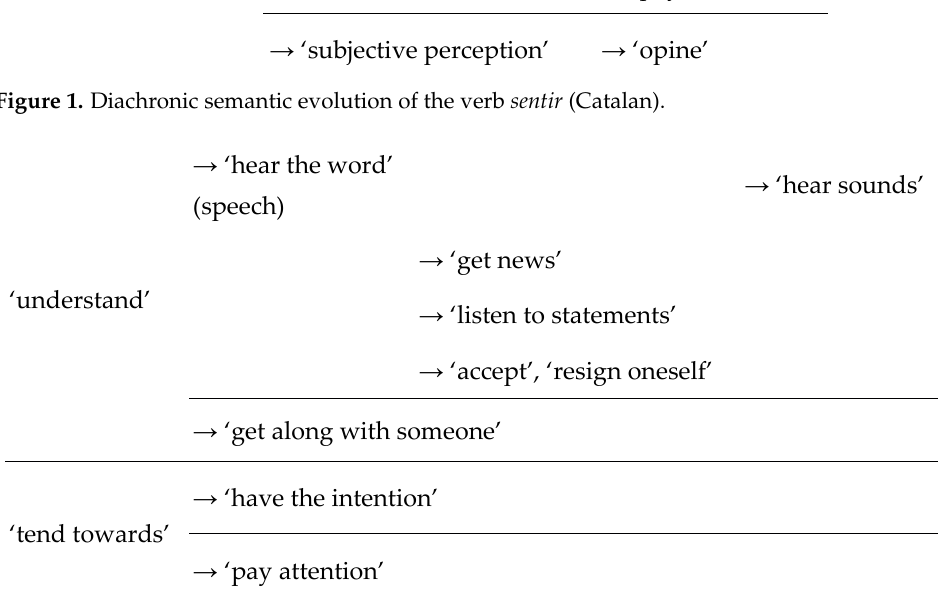
Figure 2. Diachronic semantic evolution of the verb entendre (French).